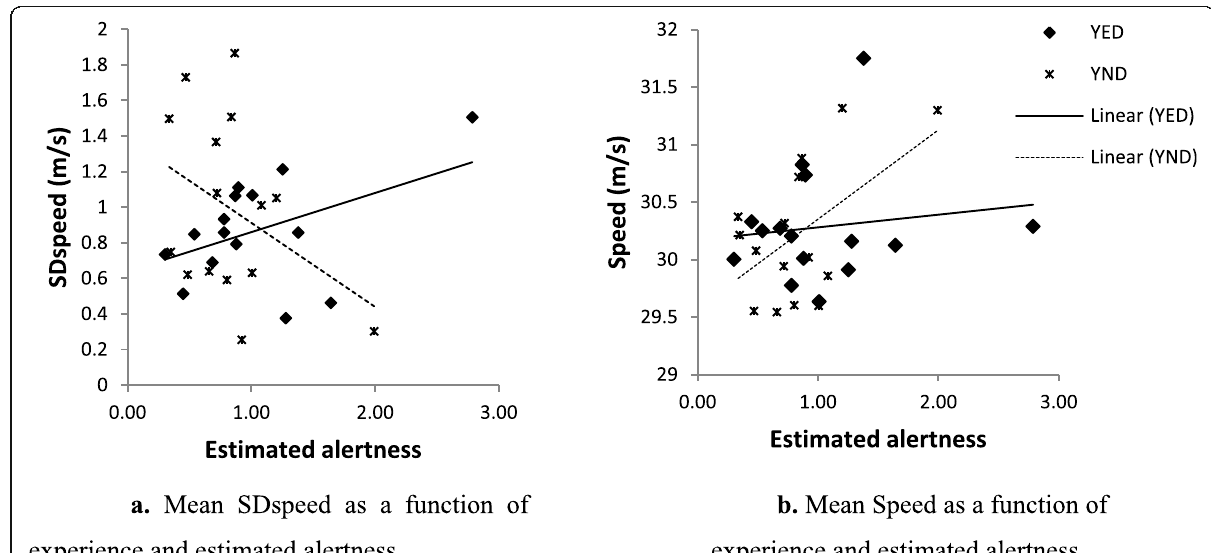
Fig. 3 a Mean SDspeed as a function of experience and estimated alertness. b Mean Speed as a function of experience and estimated